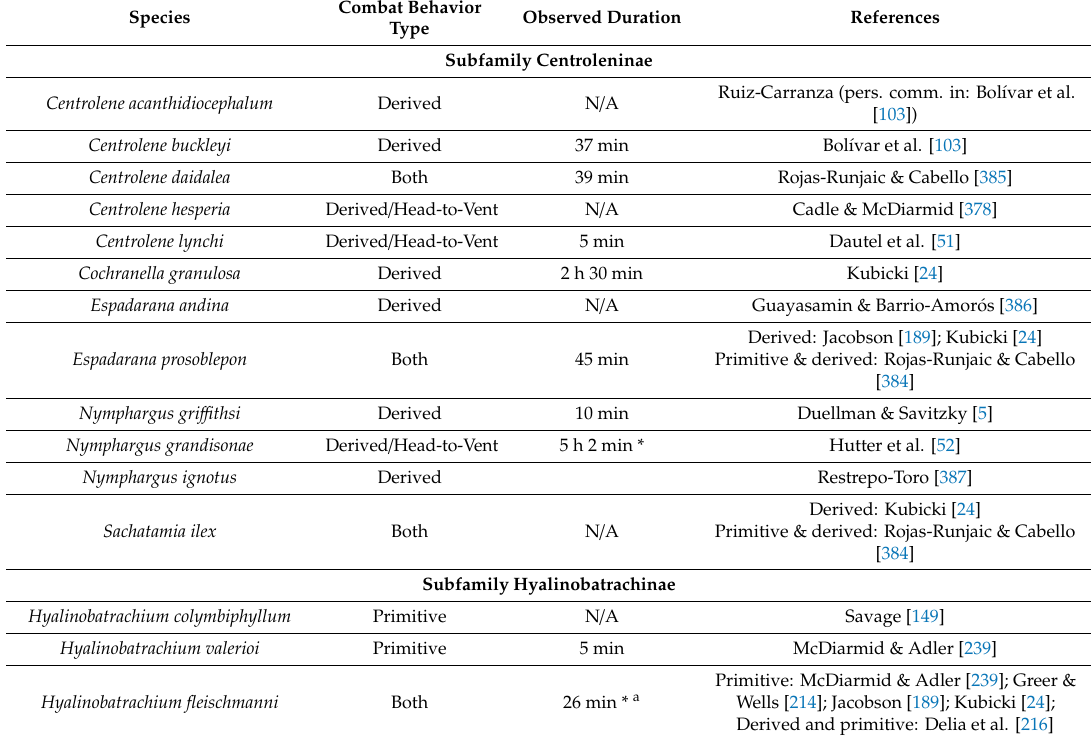
Table 9. Centrolenid species in which combat behavior has been documented, coded by the type of combat behaviors: Primitive : Combat in axillary amplexus-like position or wrestling on the leaves; derived : Combat dangling by hind limbs; both: Primitive and derived. Modified from Rojas-Runjaic and Cabello